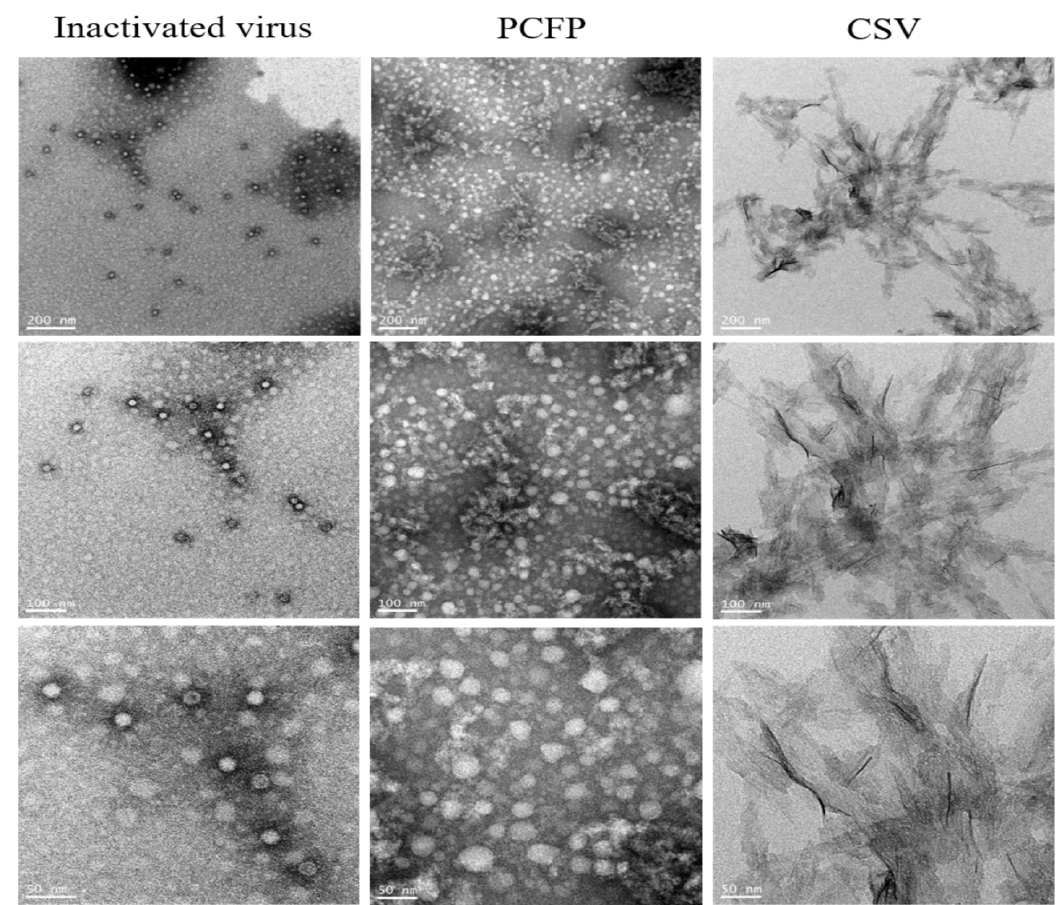
Figure 2. PCFP fusion protein spontaneously assembled into virus-like nanoparticles. The morphology of the purified PCFP protein was analyzed using a transmission electron microscope, with the inactivated virus and a commercial subunit capsid protein as reference controls. Morphological analysis indicated that PCFP fusion protein formed virus-like nanoparticles with a similar morphology to that of the original